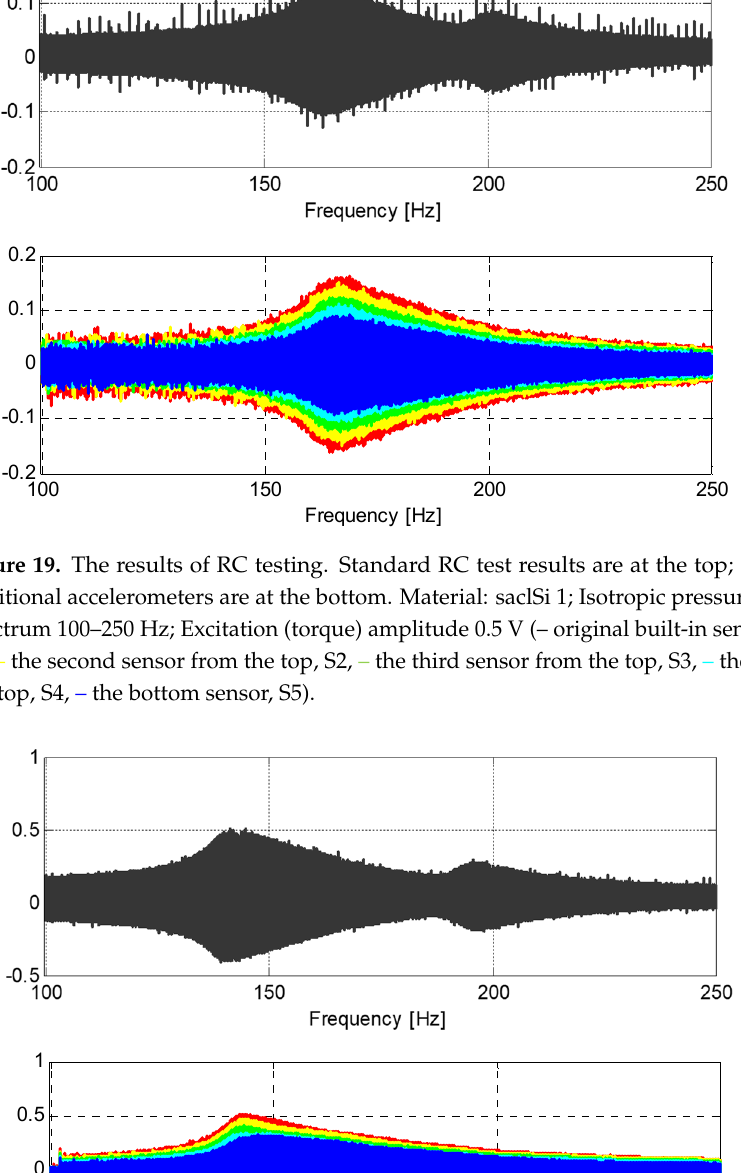
Figure 18. The results of RC testing. Standard RC test results are at the top; the results from the additional accelerometers are at the bottom. Material: Sand 3 (Sa); Isotropic pressure 100 kPa; Frequency spectrum 70–220 Hz; Excitation (torque) amplitude 4 V (– original built-in sensor, – the top sensor, S1, – the second sensor from the top, S2, – the third sensor from the top, S3, – the fourth sensor from the top, S4, – the bottom sensor, S5).